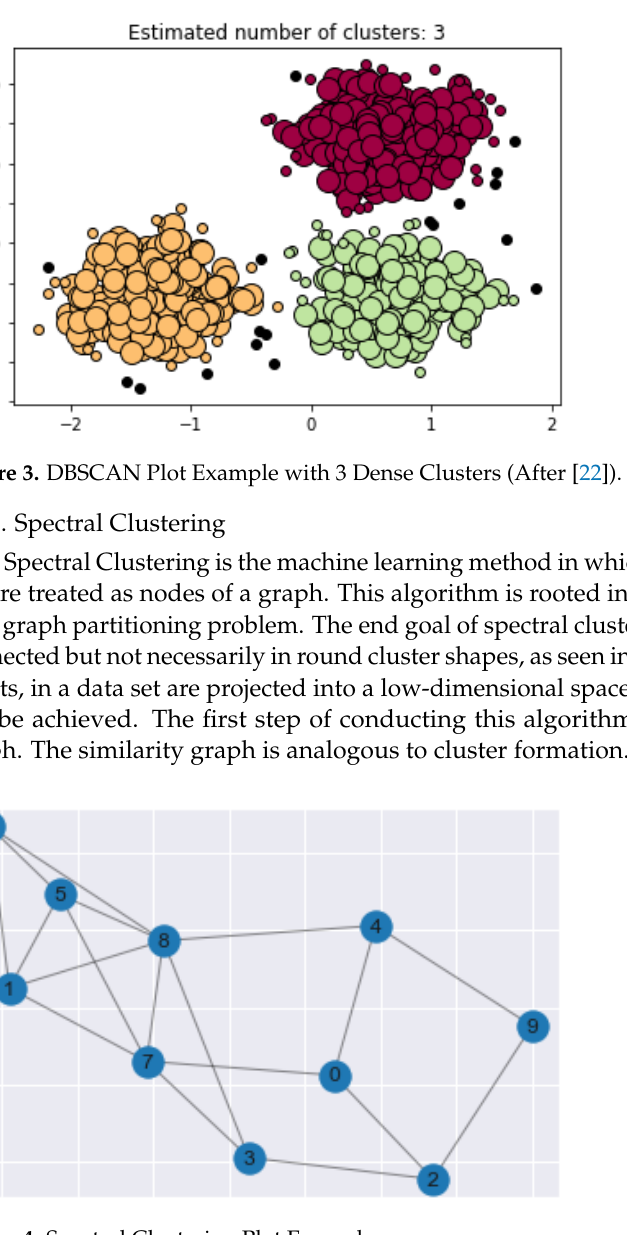
Figure 4. Spectral Clustering Plot